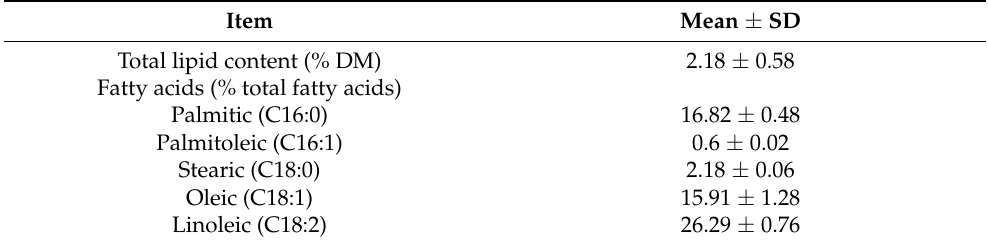
Table 3. Total lipid content and fatty acid profile of A. iva leaves ( n = 3 samples, 3 replicates per